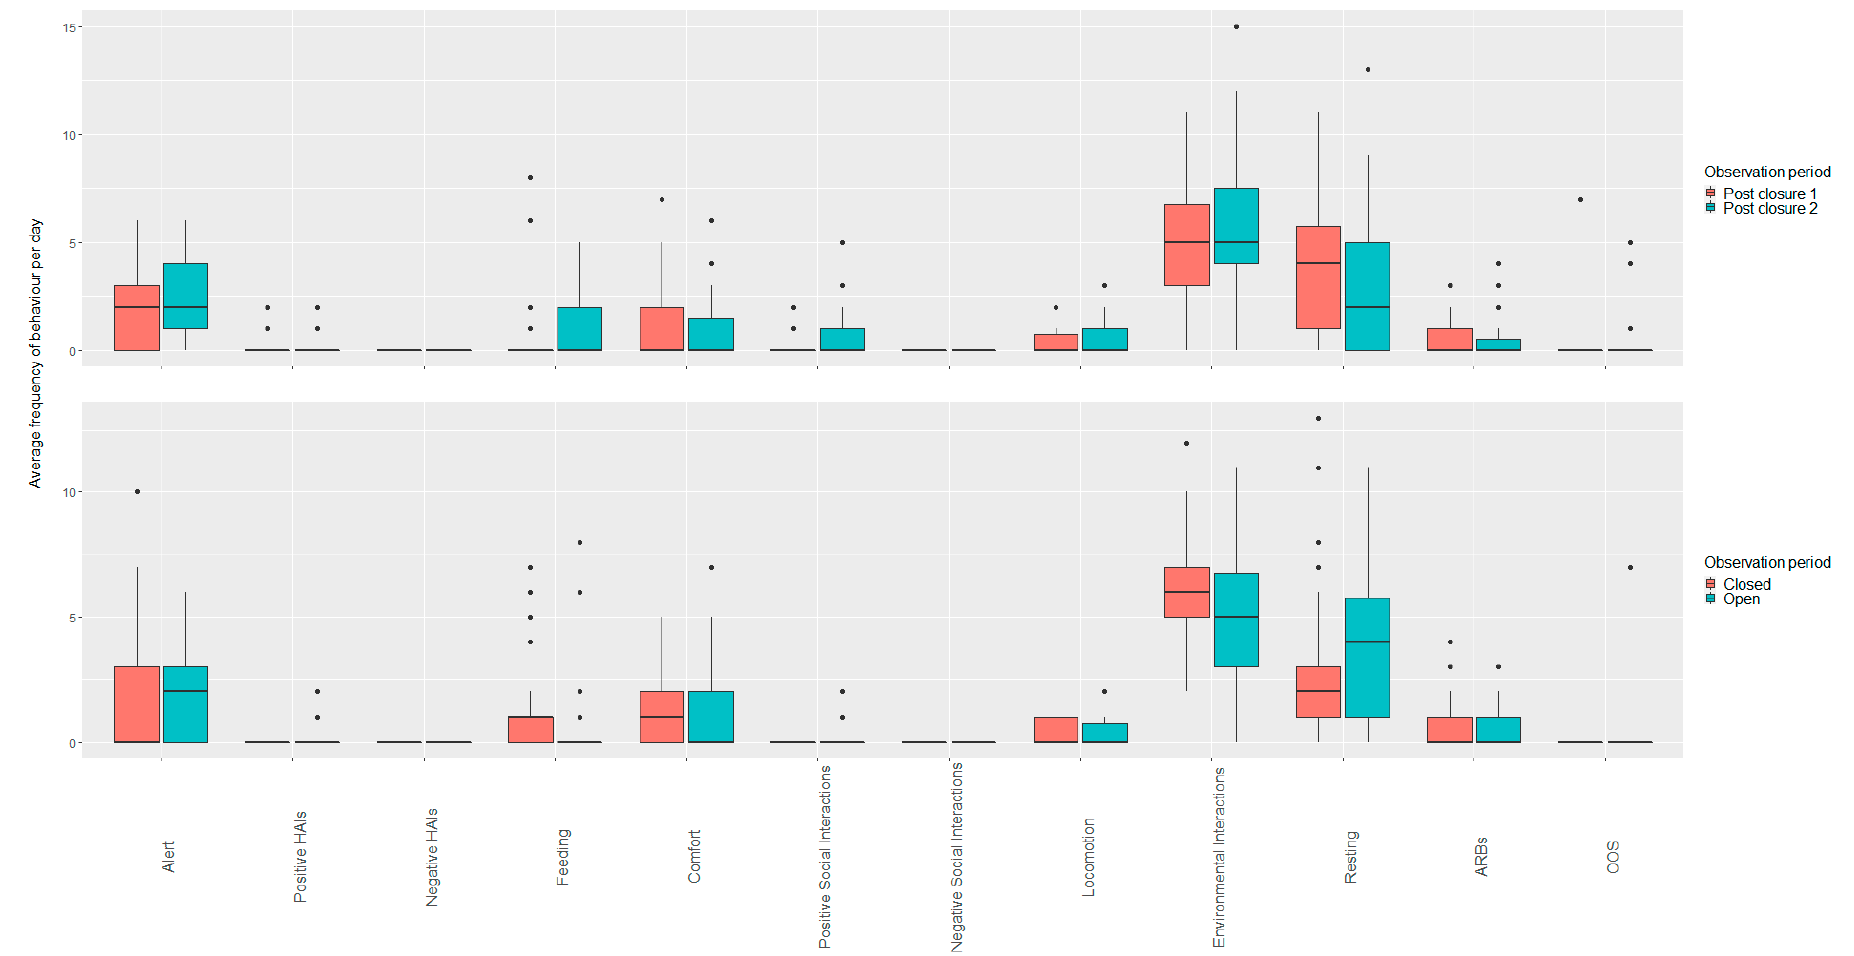
Figure 7. An overview of activity throughout the closure and reopening periods for meerkats housed at Plantasia. Dots represent outliers.